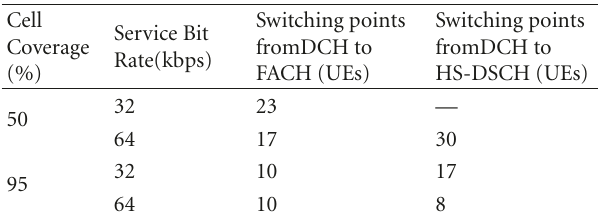
Table 5: Indicative switching